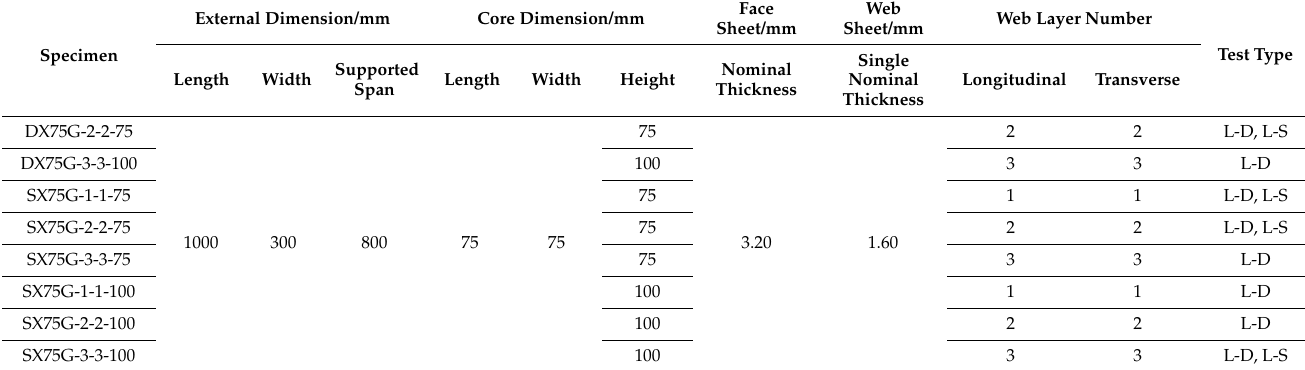
Table 4. Details of specimens.